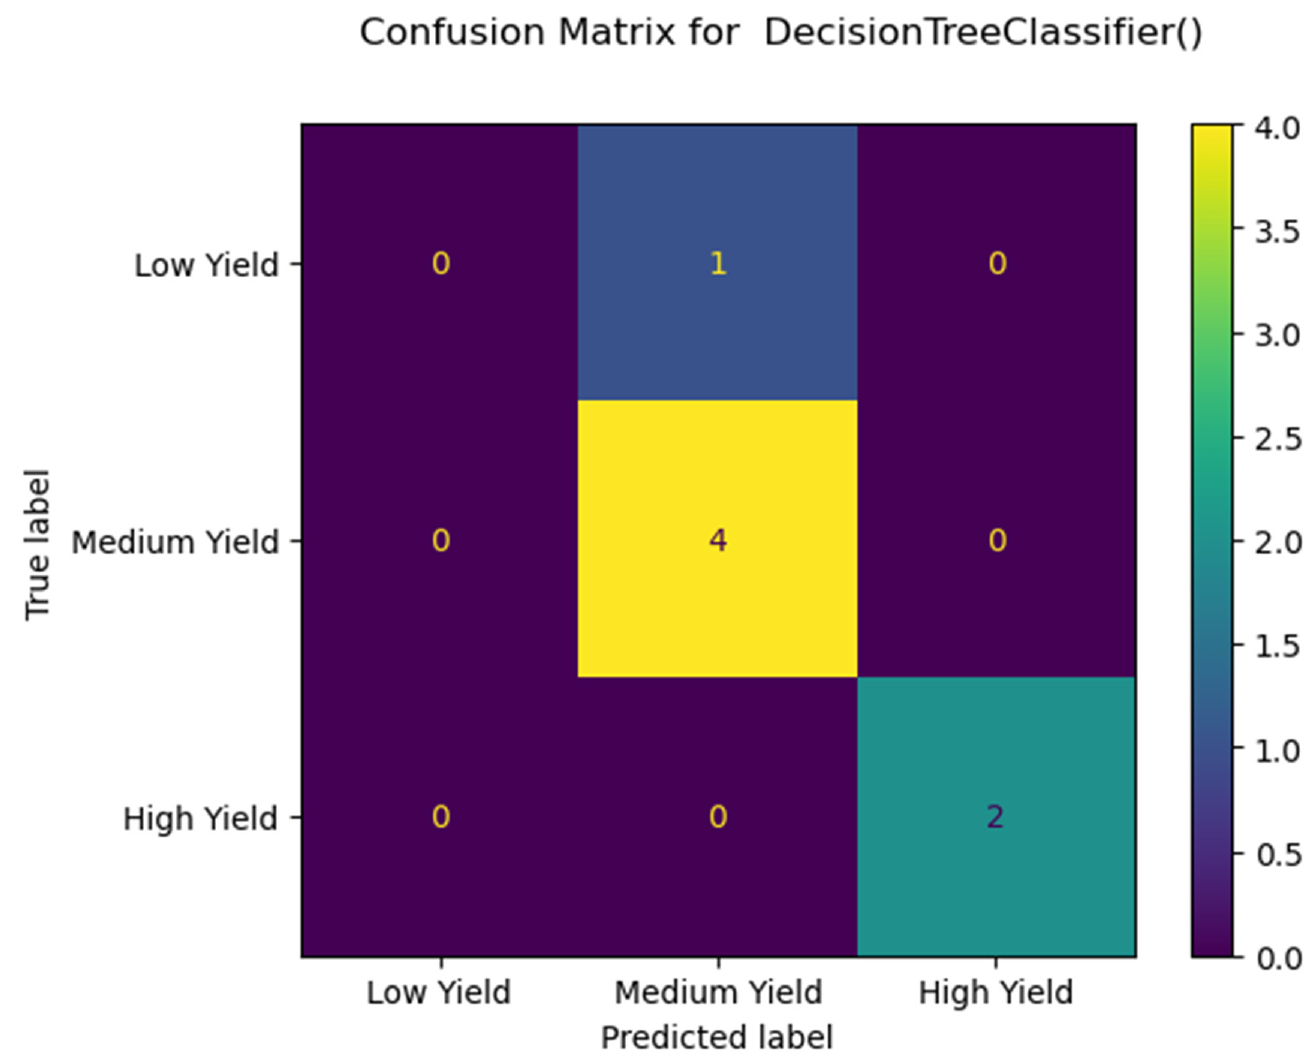
Figure 2. Confusion matrix for Table 4 best accuracy of 85.7% using DT and CTG with 1000 sam- ples.